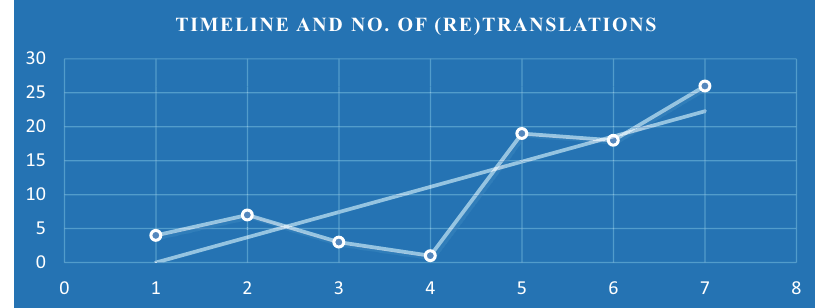
Figure 1: Dynamics of translated twentieth and twenty - fi rst century Australian